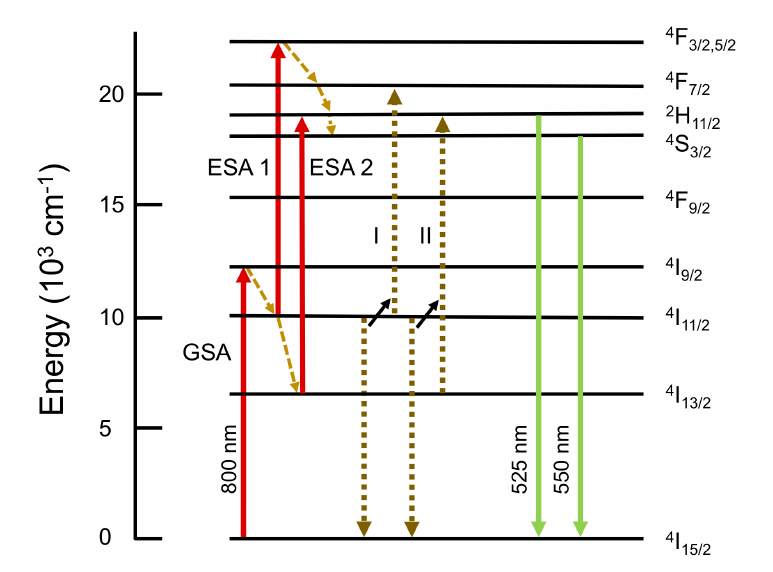
Figure 8. Energy level of Er 3+ ions in aluminosilicate glass and possible upconversion mechanisms under excitation at 800